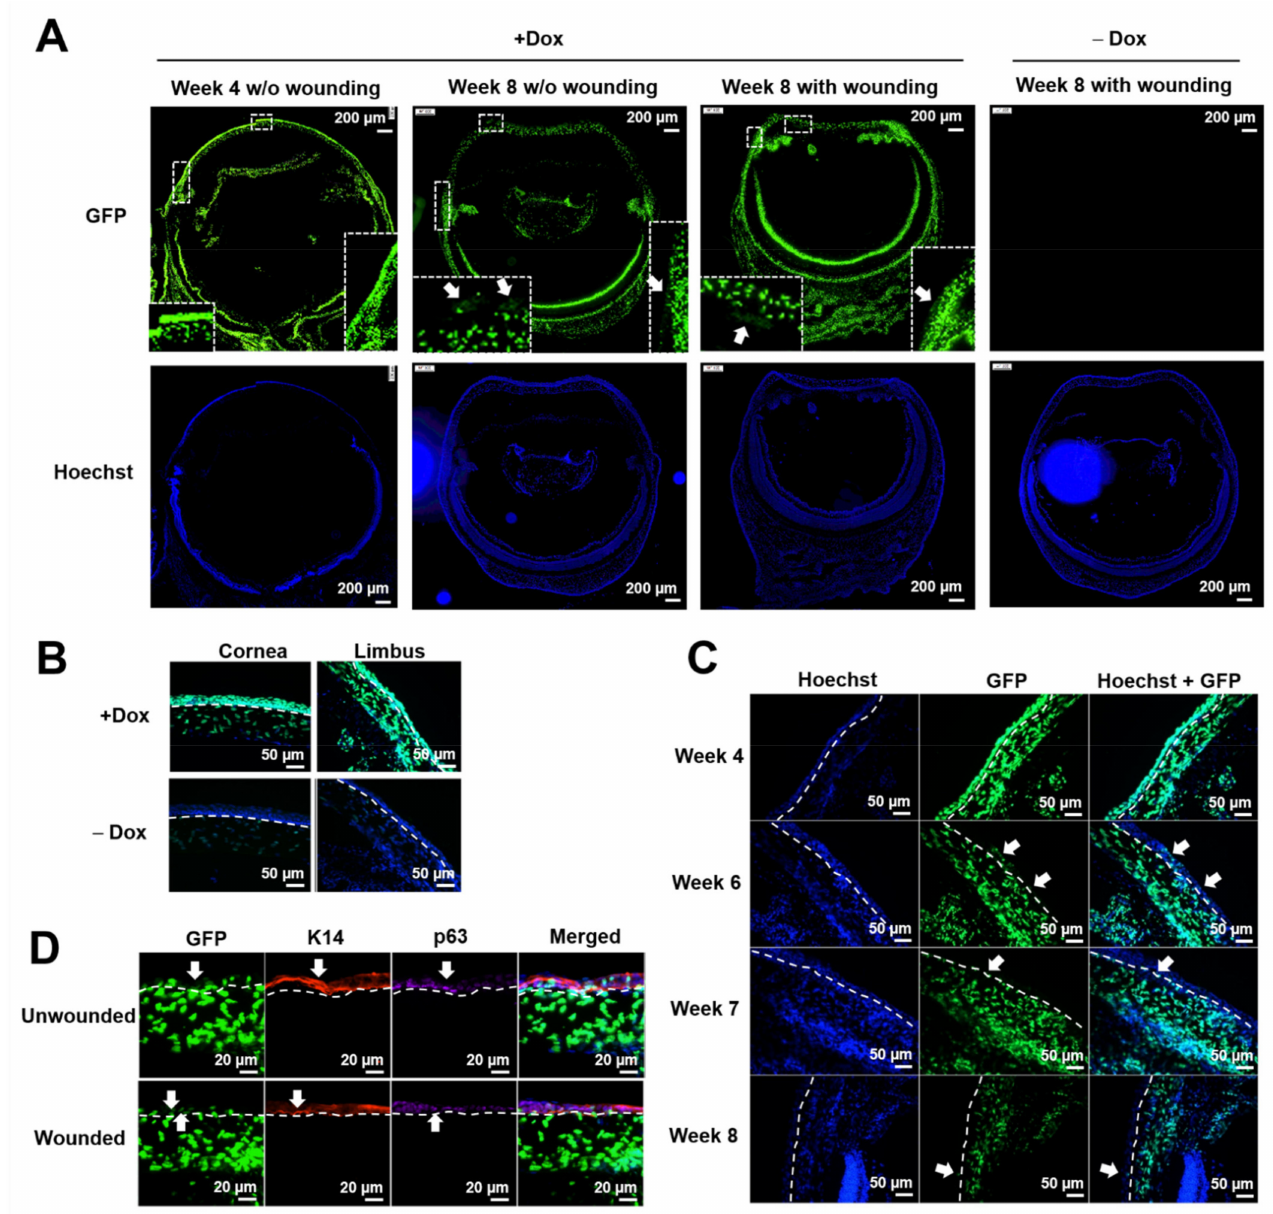
Figure 2. Validation of the label-retaining transgenic mouse model for the study of LSCs. ( A ) Repre- sentative pictures showing whole-eye cross sections of the H2B-GFP mice with or without doxycycline induction. Corneal and limbal epithelial and stromal cells were labeled with strong GFP at the be- ginning of chase phase (“Week 4”). At the end of chase phase (“Week 8”), majority of corneal and limbal epithelial cells lost their GFP label and the label retaining cells located as discrete cell clusters on corneal and limbal epithelium under normal homeostasis (“Week 8 w/o wounding”) and